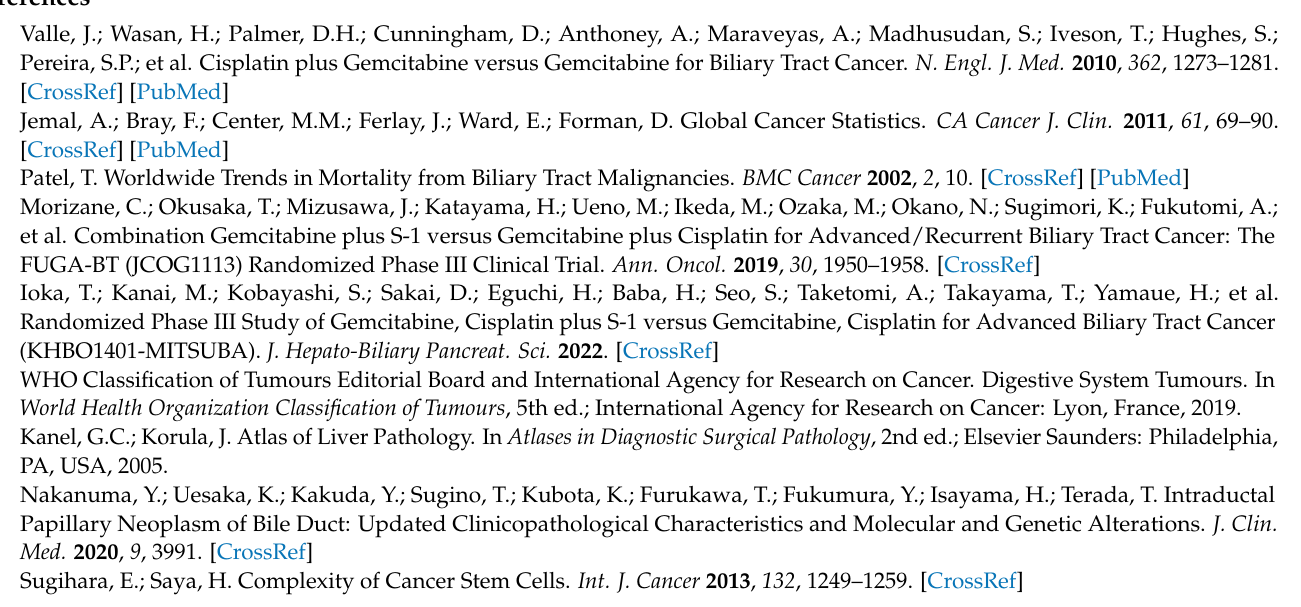
Supplementary Figure S3: Clusters and annotations of human cholangiocarcinoma tissue